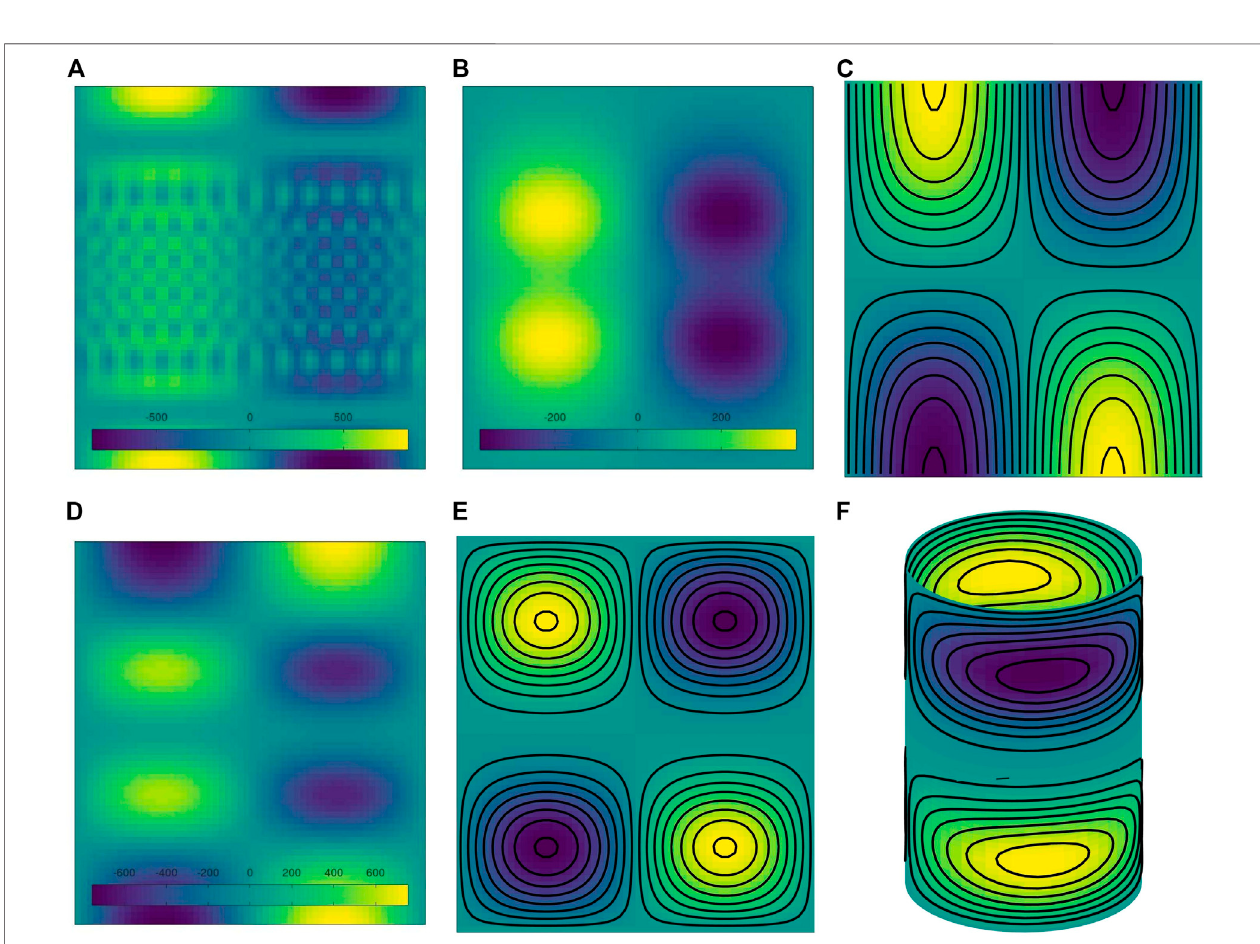
FIGURE2| Differentstepstoillustrategradientcoildesignbasedonasurfacecurrentdensity.Scalesarein[ A ]. (A) Anun-regularizedcurrentdensityresultsinhigh opposing currents and is therefore very inef fi cient. (B) Regularization penalizes opposing currents. (C) Integration along the z yields the stream function. However, the discrete wire paths which are given by streamlines are not realizable by closed loops. (D) An additional constraint is added to ensure that the sum of currents along z equals zero. (E) The corresponding wire paths are now realizable as closed loops. (F) A 3D-rendering may be plotted by the supplied code.